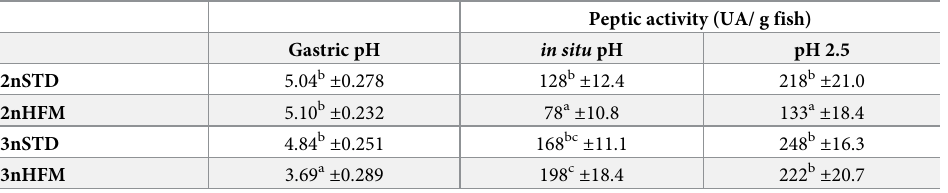
Table 5. Gastric pH ( ± SE) at 2745 ddPSF sampling in the four experimental fish groups and peptic activity (UA/g of fish) measured at in situ gastric pH and at pH 2.5.